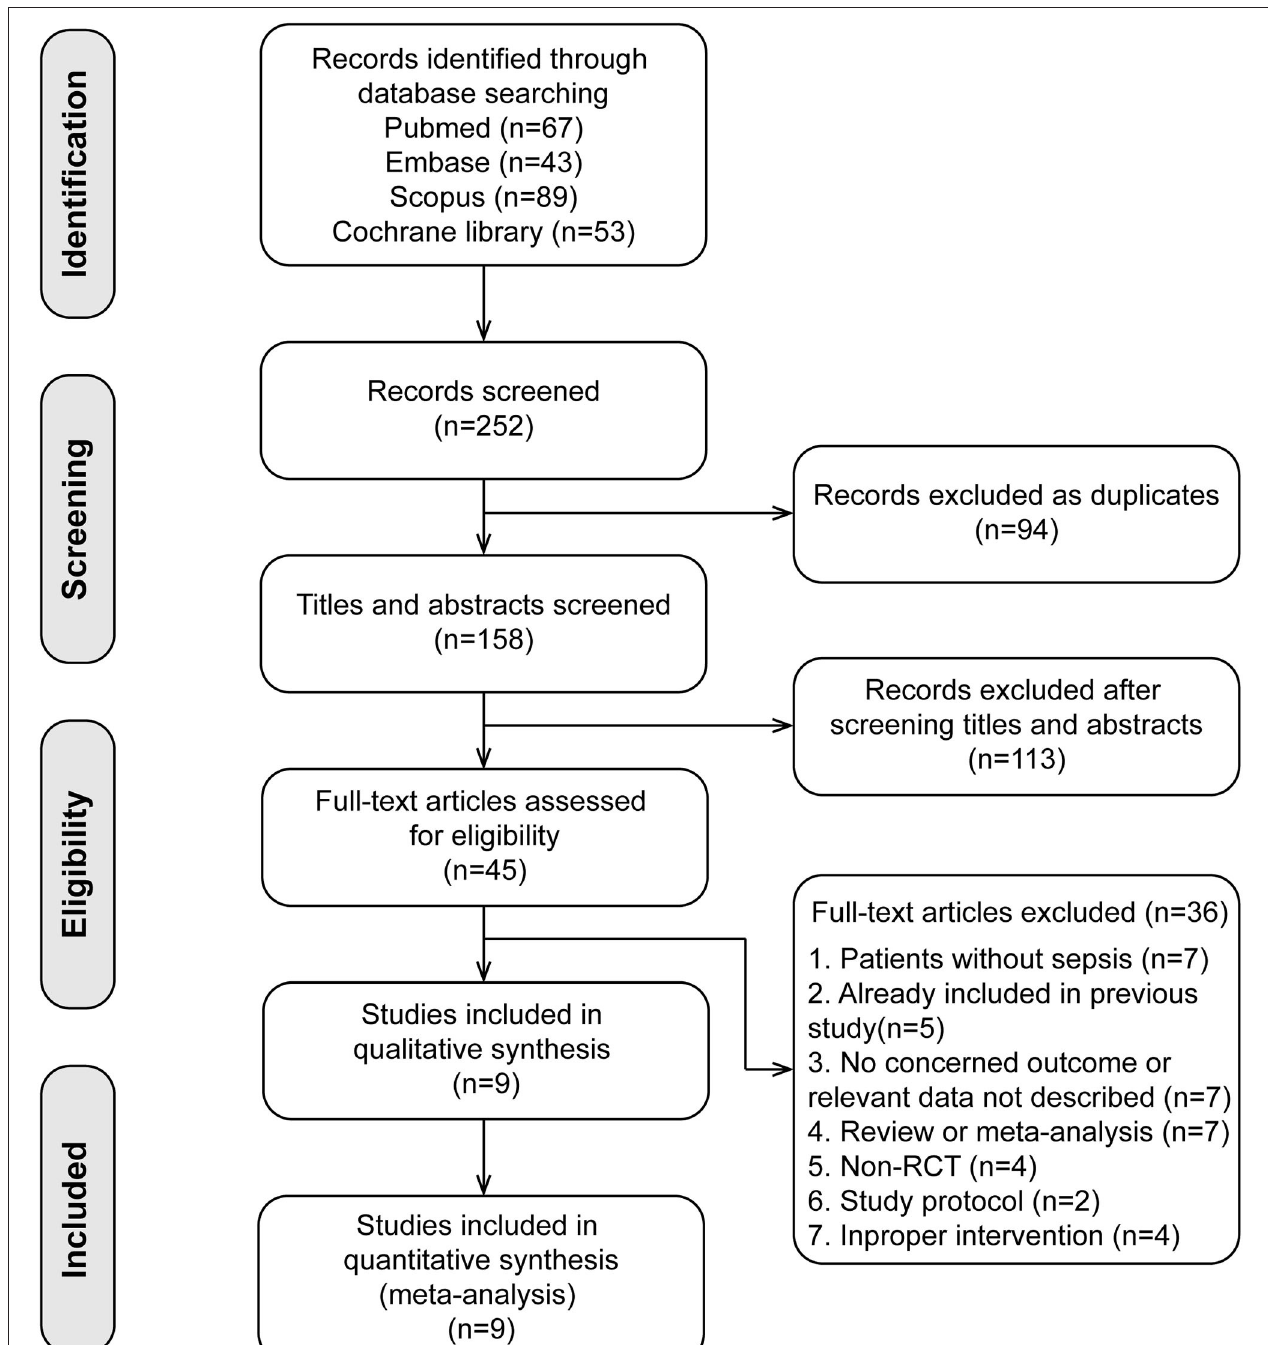
FIGURE 1 | Flow chart of database search and study selection.